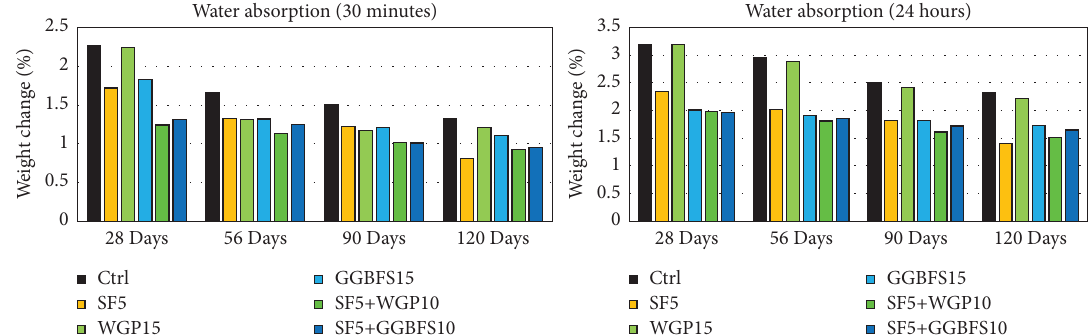
Figure 12: Water absorption test results of concrete mixtures.